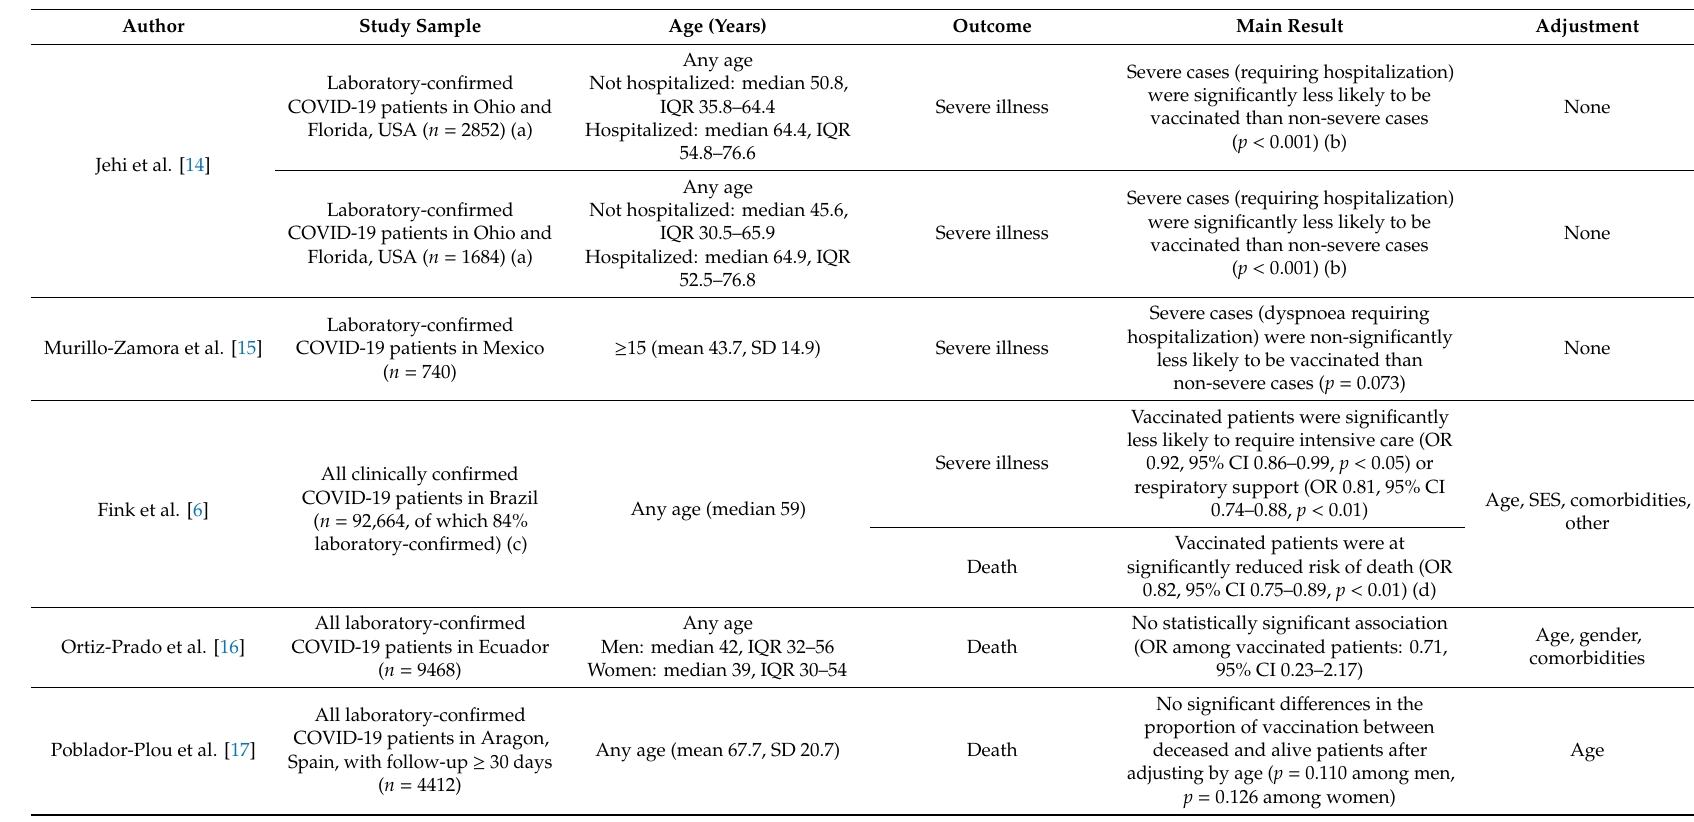
Table 2. Main features and results of studies on the association between influenza vaccination and the risk of severe illness or death among COVID-19